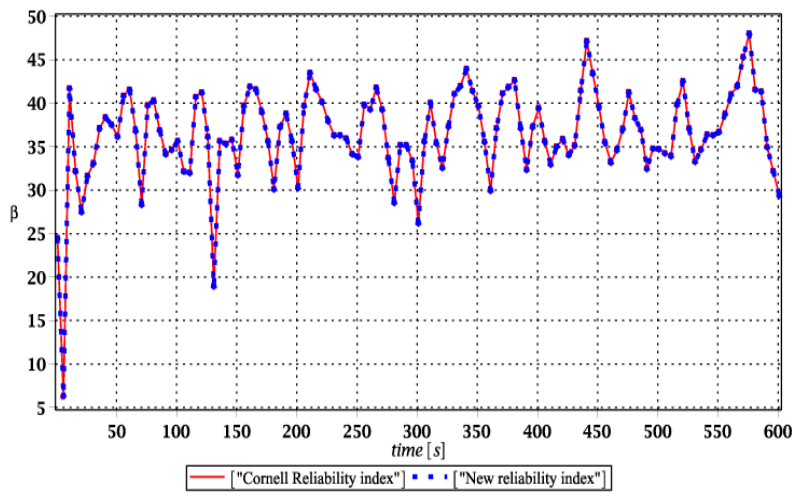
Figure 10. The comparison of dynamic reliability indices for uncertain Young’s modulus.